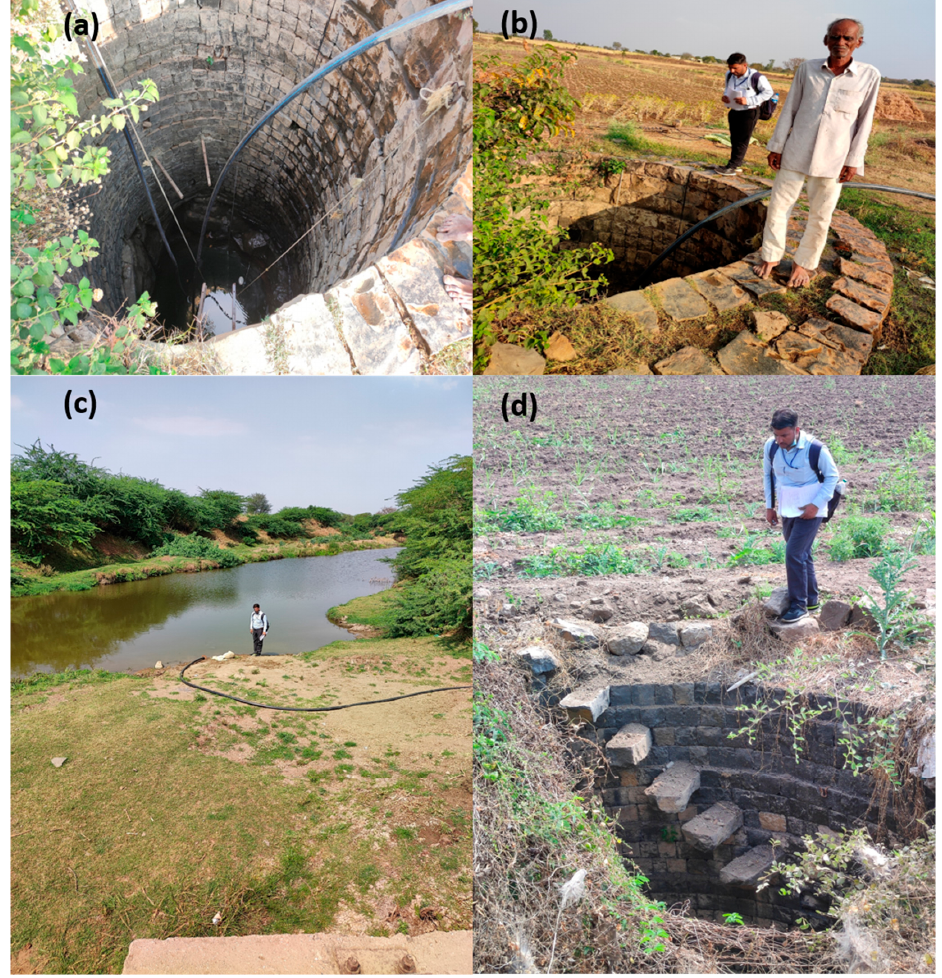
Figure 8. Visuals from the field survey: ( a , b ) Pumping of groundwater ( c ) Perennial surface water body ( d ) Dried well.